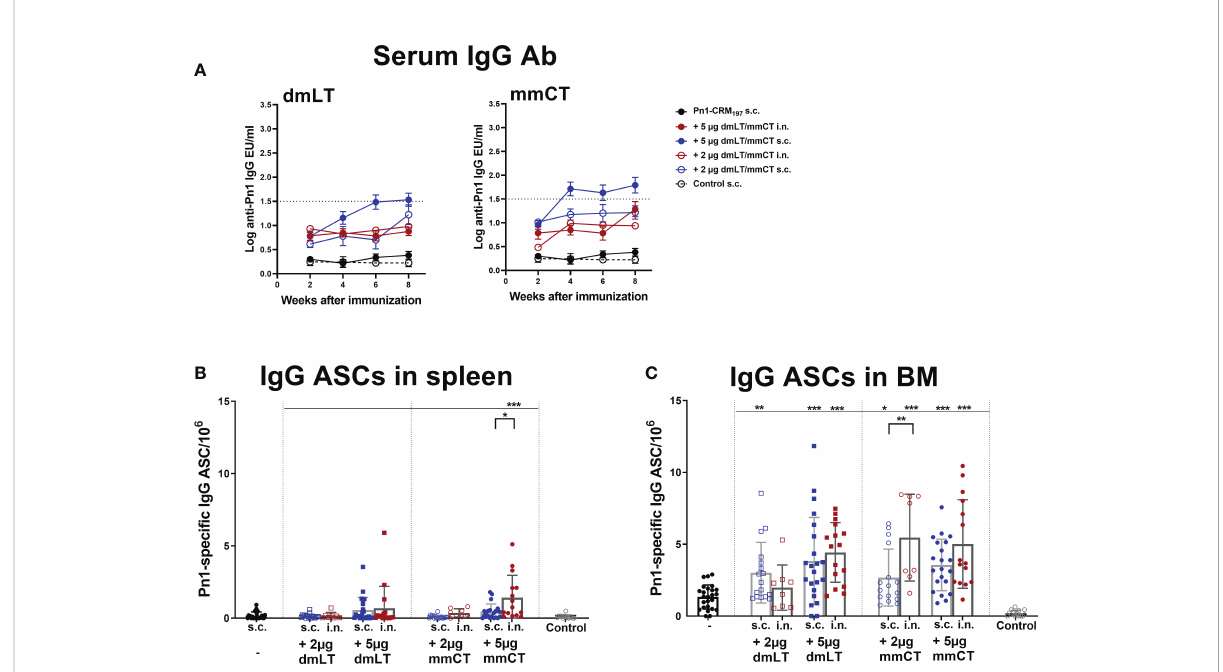
FIGURE 1 Adjuvants dmLT and mmCT enhance humoral immune responses irrespective of the immunization route. Pn1-speci fi c serum IgG Ab levels 2, 4, 6 and 8 weeks (A) and number of Pn1-speci fi c IgG + ASCs in spleen (B) and BM (C) 8 weeks after s.c. or i.n. immunization of neonatal mice with Pn1-CRM 197 with or without 2µg or 5µg of adjuvants dmLT or mmCT or saline-injected mice as controls (A) . Results are expressed as IgG levels (log mean EU/ml ± SEM), and number of spots/10 6 cells (mean ± SEM), in 3 comparable independent experiments combined (except the groups immunized i.n. with Pn1-CRM 197 with 2µg of dmLT or mmCT where there are 8 mice per group). Statistical difference was calculated using Mann – Whitney U-test where adjuvant groups were compared to vaccine only group and immunization routes were compared between the adjuvanted groups. *p ≤ 0.05, **p ≤ 0.01, ***p ≤ 0.001. The dotted line representes protective IgG Ab levels for pneumococcal